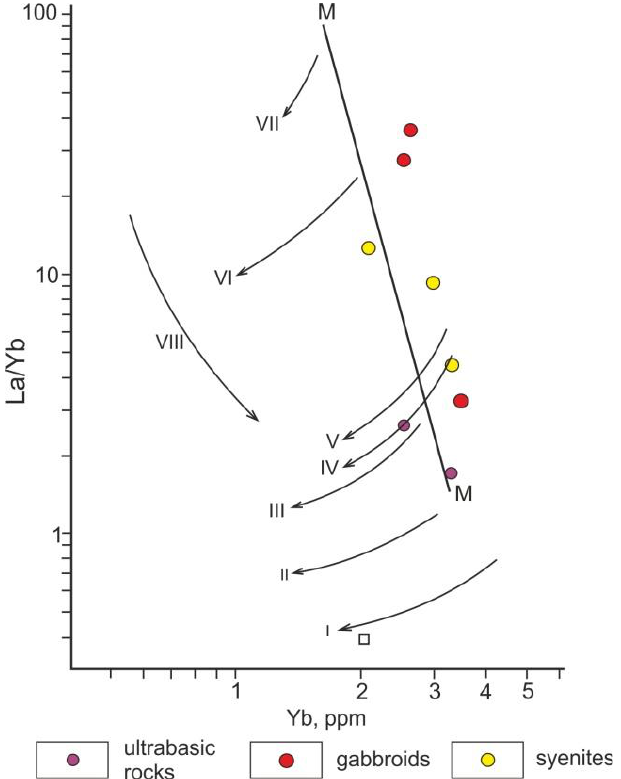
Figure 19. La/Yb vs. Yb diagram for igneous rocks of the Tommot massif. Differentiation trends [68]: I — depleted plagioclase lherzolites, II — depleted spinel lherzolites, III – V — primitive spinel lherzolites, VI and VII — metasomatically enriched lherzolites, M-M — trend of mantle enrichment.